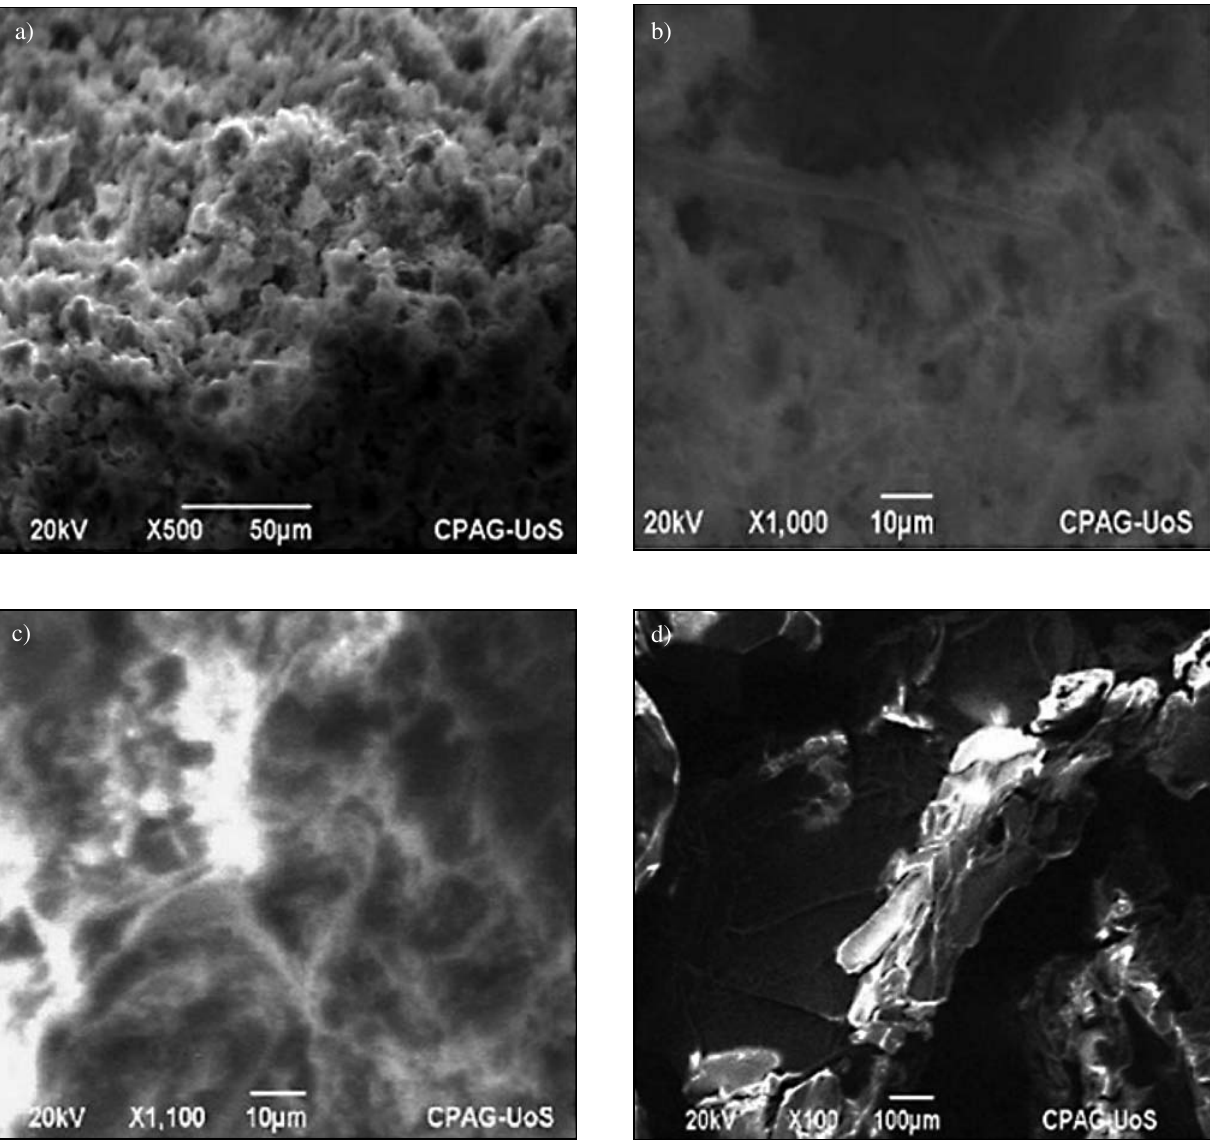
Figure. 2 SEM Images of (a) PHOBen (b) PHOBPR (c) PHOBPh and (d) PHOBP conditions as